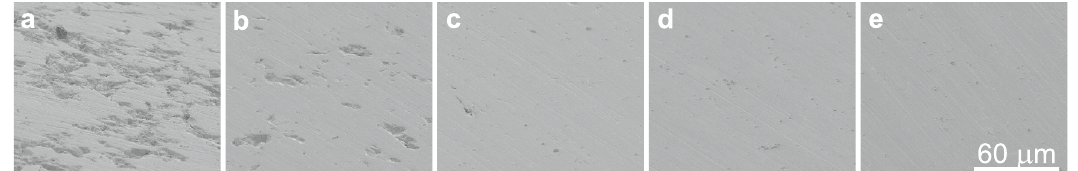
◦ ◦ ◦ C, ( b ) 250 C, ( c ) 500 C, ( d )